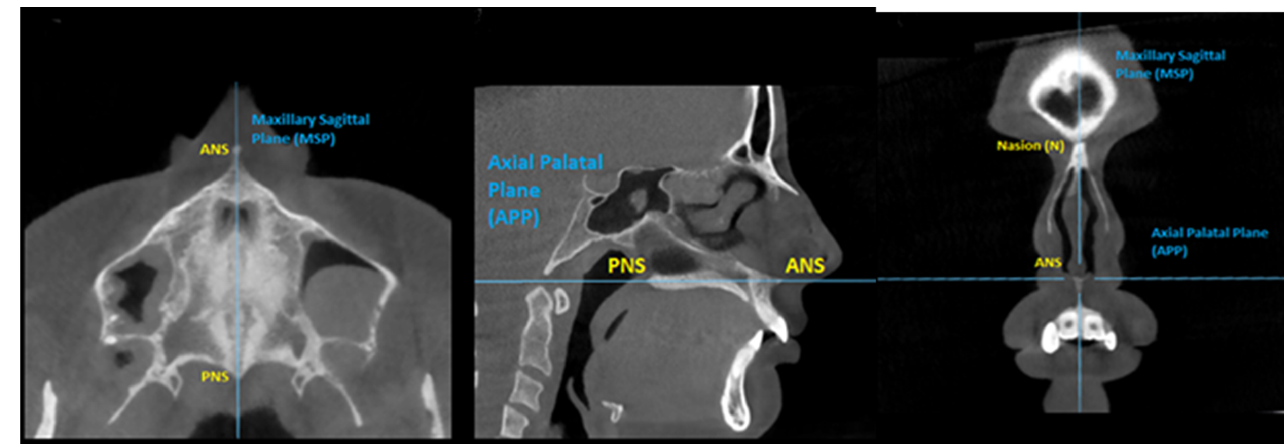
Figure 3. Identification of the reference points for the midsagittal plane at the axial, sagittal and coronal sections.